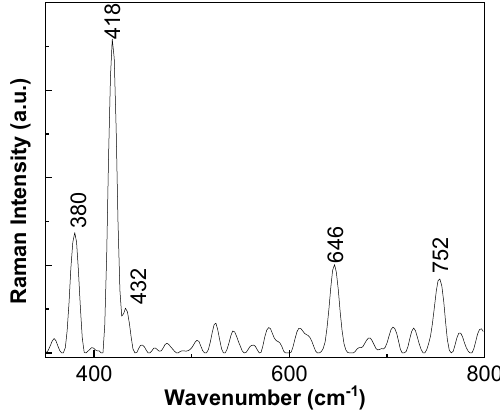
Figure 2. Infrared spectrum of the sample. Figure 3. The Raman spectrum of the Ox NPAMs sample. Figure 3. The Raman spectrum of the Ox NPAMs